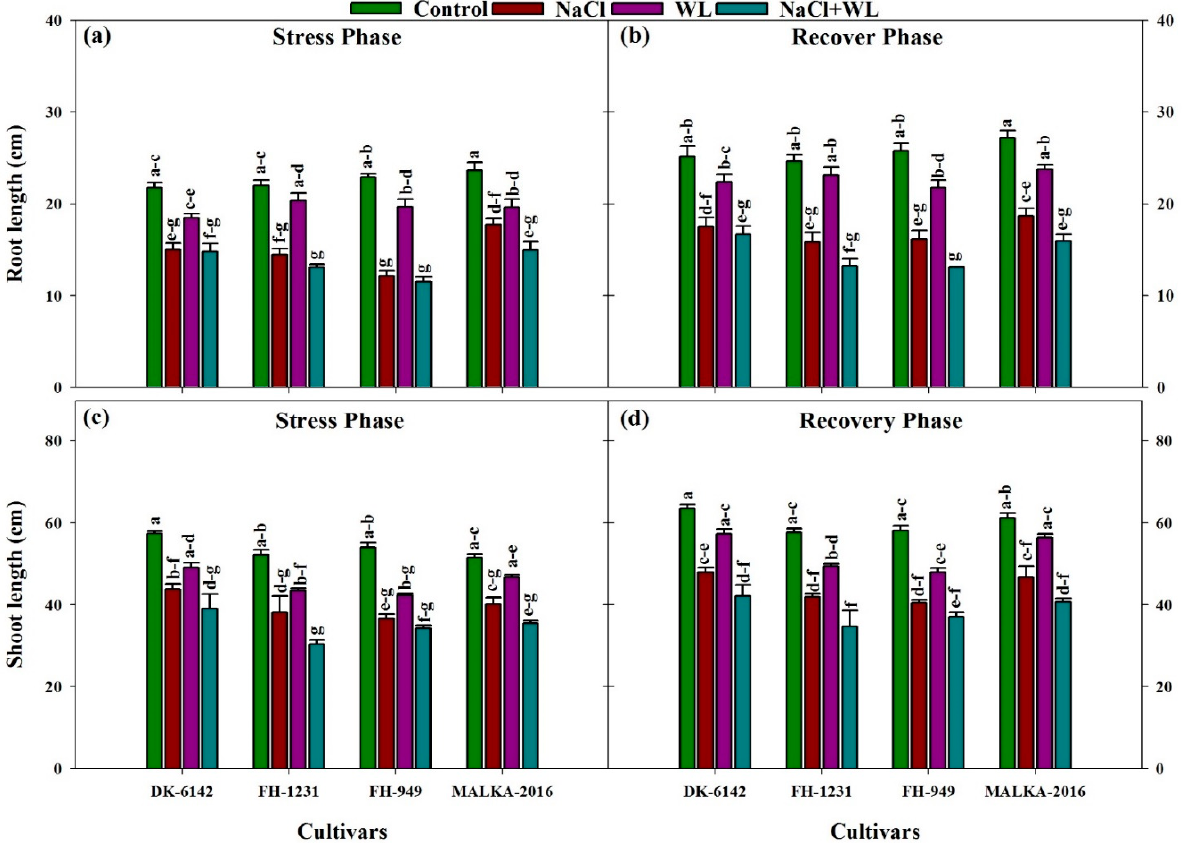
Figure 1. Individual and interactive effects of salinity and waterlogging on the shoot and root lengths of four maize hybrid cultivars during the stress (22 DAS) and recovery (30 DAS) phases. Left and right sides of the figure are representing stress phase and recovery phase respectively. Error bars denote the standard error of three replications. Bars with the same letters do not differ significantly at p ≤ 0.05.